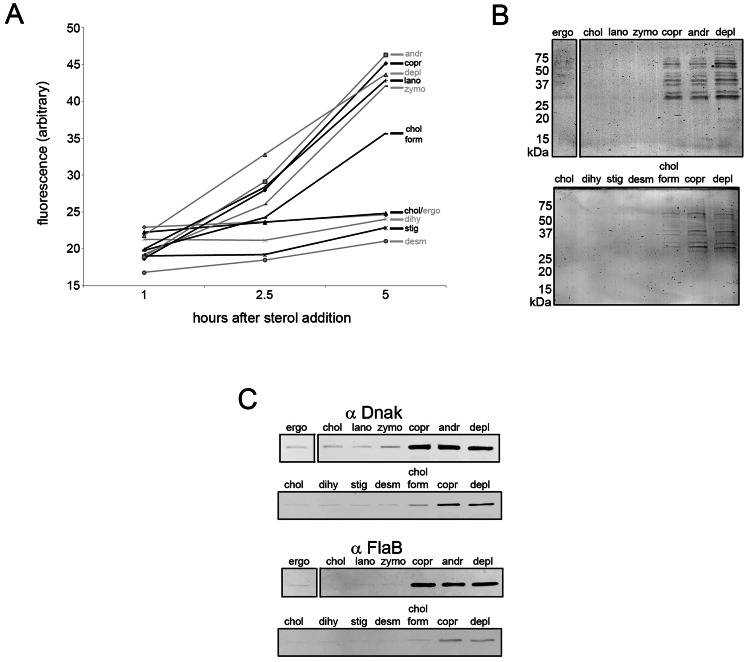
Sterols that differ in raft-forming ability have differential effects on B.
burgdorferi membrane permeability.
A. Propidium iodide staining of B. burgdorferi substituted with the indicated sterols. The x axis shows incubation time at 33°C after sterol substitution. The mean of three experiments each of which had three samples is shown. Standard error of the mean values (not shown to enhance figure clarity) were typically ±1 fluorescence units and did not exceed ±2 fluorescence units for any data point. B. Representative Coomassie-stained SDS-PAGE gels of supernatants from B. burgdorferi 5 h after substitution with the indicated sterols. Approximate M.W. shown at left of gels. C. Representative immunoblots showing the release of the cytosolic chaperone DnaK and periplasmic flagella subunit FlaB into the supernatants 5 h after substitution with the indicated sterols. Key; depl = sterol-depleted, ergo = ergosterol, chol = cholesterol, lano = lanosterol, zymo = zymosterol, copr = coprostanol, andr = androstenol, chol form = cholesterol formate, stig = stigmasterol, dihy = dihydrocholesterol, desm = desmosterol.